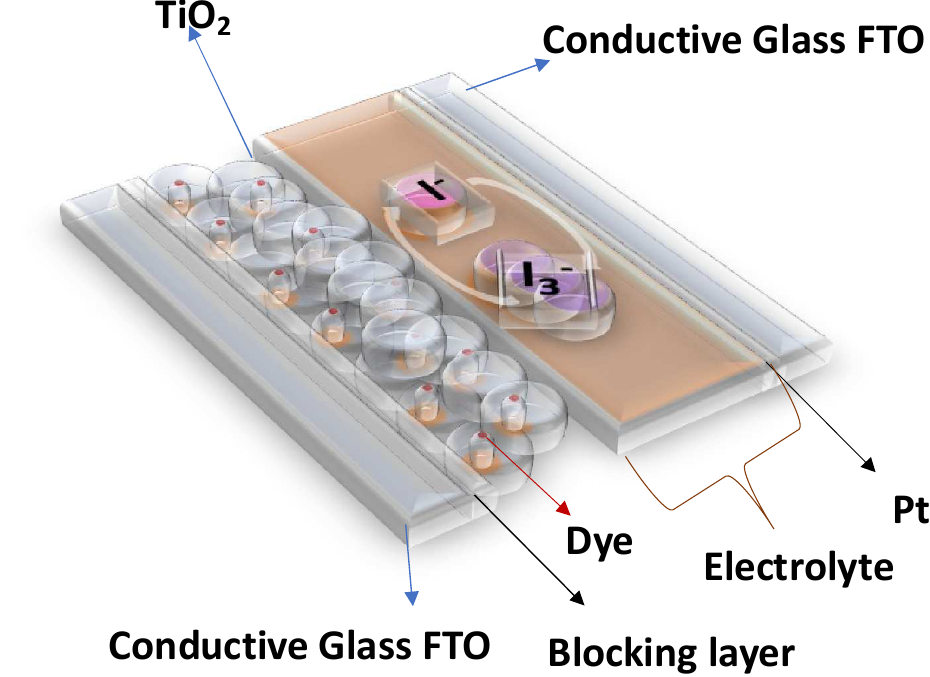
Figure 1. General structure of a Dye-Sensitized Solar Cell (DSSC). To date, the implementation of COFs in DSSCs has rarely been explored. Herein, different 2D COFs named RIO-43, RIO-55, RIO-70, RIO-60, and DAAQ-COF were tested as dyes, thus exploring their versatility for use in DSSC applications (see Figure